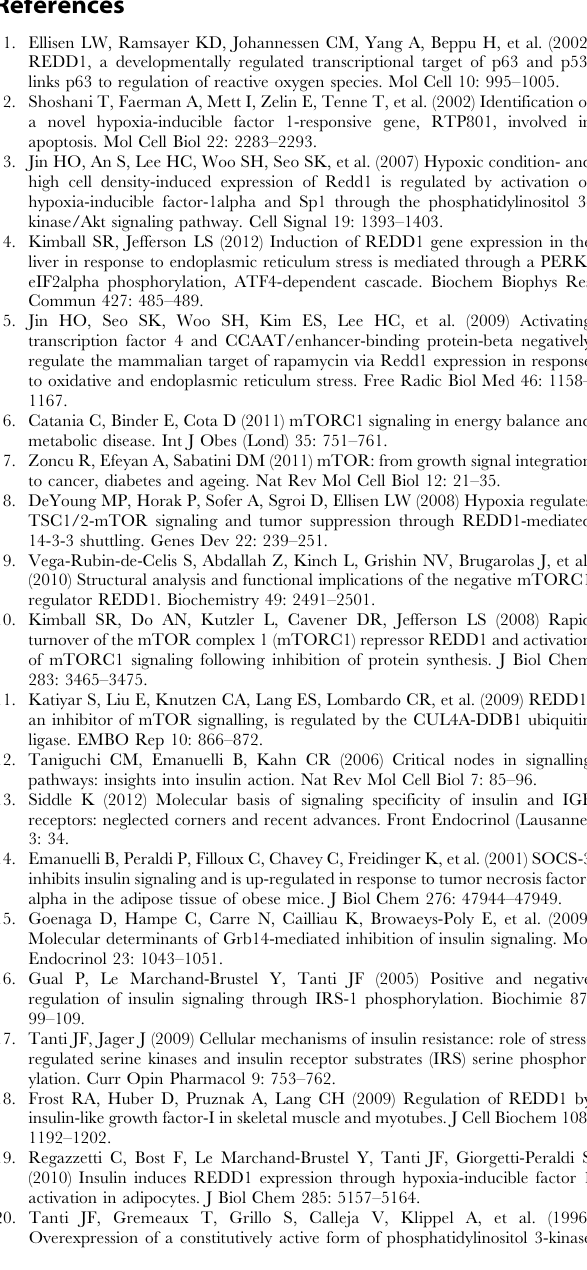
Figure S2 3T3-L1 adipocytes were transfected with REDD1 siRNA ( # 1: s93077, # 2: s93078, # 3: 74747) as mentioned in materials and methods. 48 h after trans- fection, adipocytes were stimulated with insulin (10 nM) for 5 minutes. Proteins were analyzed by immunoblots using indicated antibodies. Figure S3 3T3-L1 adipocytes were transfected with REDD1 siRNA. Adipocytes were stimulated with insulin for 5 minutes. Proteins were analyzed by immunoblots using indicated